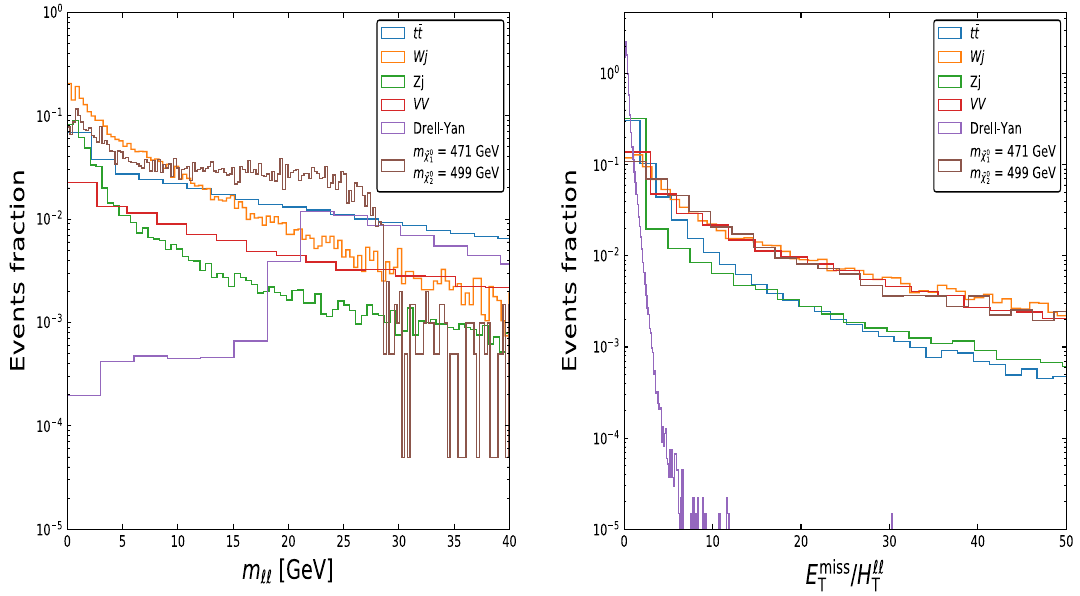
Fig. 12 The normalized distributions of m (cid:9)(cid:9) and E miss = 499 GeV, m = 498 GeV and m m ˜ χ 0 ˜ χ ± 2 1 Table 2 Ten signal regions are defined by the values of m (cid:9)(cid:9) and E miss